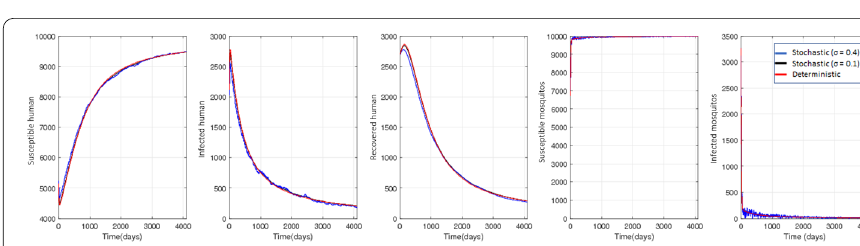
Figure 10 Model simulation with bed nets η = 0.4 and without fumigation when R 0 < 1